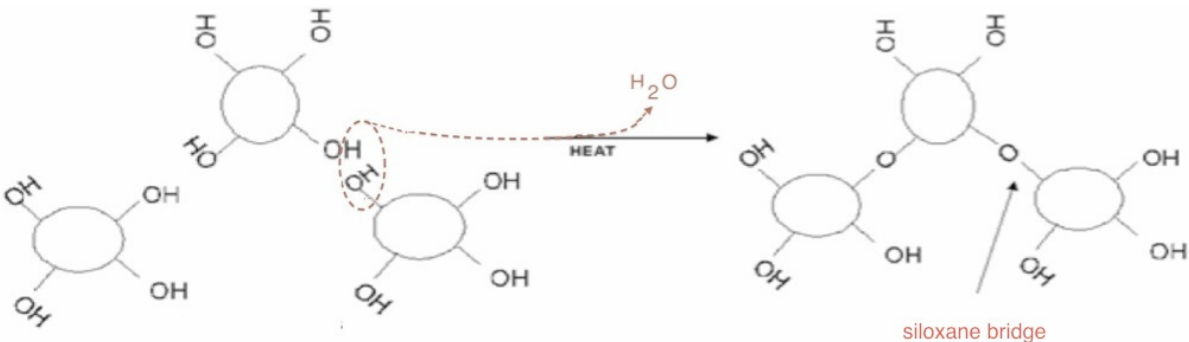
Figure 4. A representation of inter-particles condensation through siloxane bridge formation.